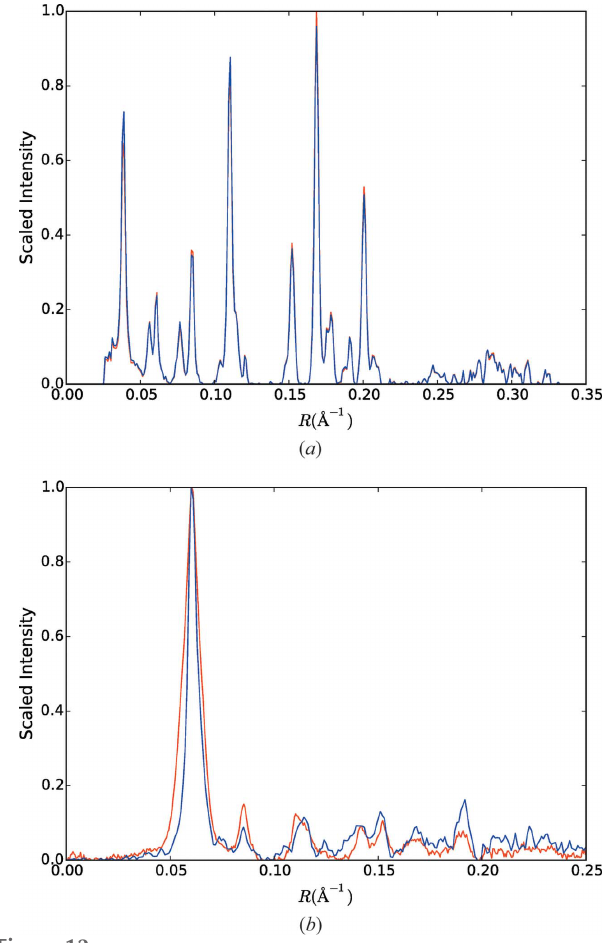
Figure 12 ( a ) Intensity profiles through the equator of the two-dimensional merged data (red) and of the cylindrically re-projected intensity through the equator of the three-dimensional merge (blue), as described in the text. ( b ) The same as panel ( a ) except for the l = 1 layer